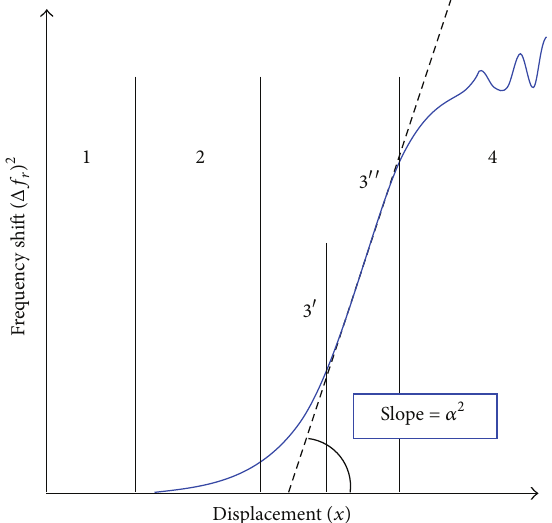
Figure 1: A plot of the characteristic regions observed for variation in the square of the resonant frequency shift ( Δ𝑓 𝑟 ) 2 with displace- ment( 𝑥 )whentheprobetipmountedtoavibratingcantilevercomes in contact with a